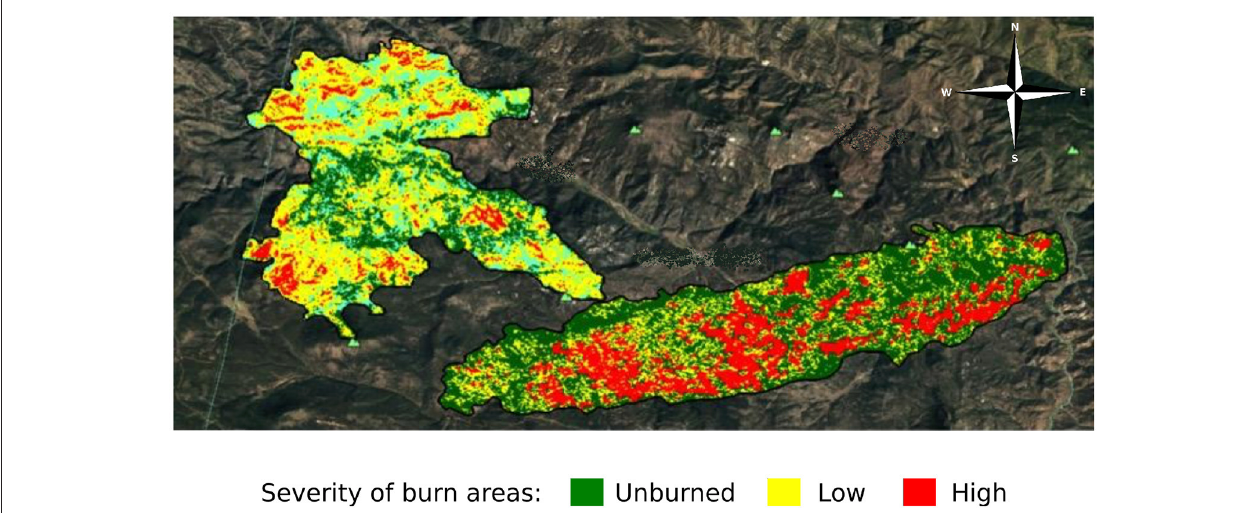
FIGURE 2 | Satellite imagery of the area burned and severity of the High Meadows fire (left) and the Buffalo Creek fire (right) in Colorado; Hayman fire not shown (MTBS Data Access: Fire Level Geospatial Data, 2016, April-last revised). Dark green indicates unburned areas, yellow indicates low severity burn areas, and red indicates high severity burn